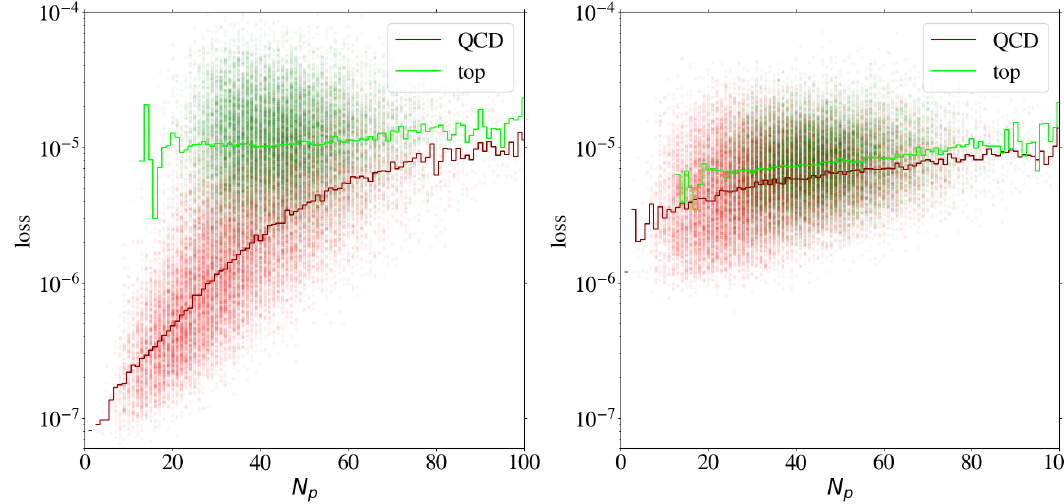
Figure 6 . Reconstruction loss of individual test jets (only half of the test set is shown as points in the scatter plot) as a function of the number of non-zero pixels N p , for an AE trained on QCD jets (left) and top jets (right). QCD (top) jets are shown in red (green). The solid lines show the median loss for a given number of non-zero